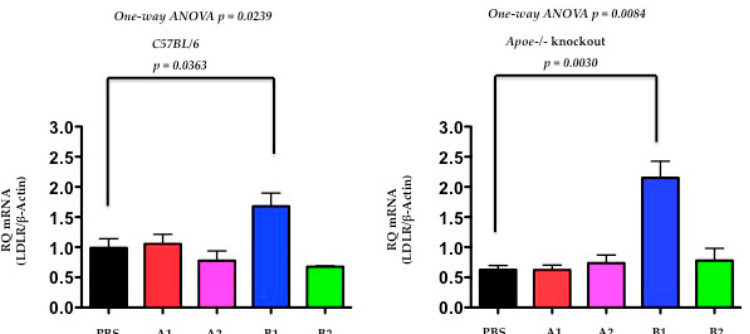
Figure 6. The hepatic mRNA levels of LDL receptor were significantly increased at day 120 after X-PCSK9-B1 treatment in both C57BL/6J and Apoe − / − mice. The authors extracted total RNA from mouse liver at day-120 after X-PCSK9 immunogen treatment. The authors used real-time RT-PCR to quantify the mRNA levels of LDL receptors (LDLR). The results are expressed as RQ (LDLR mRNA normalized with β -Actin; mean ± SEM, black = PBS; red = X-PCSK9-A1; pink = X-PCSK9-A2, blue = X-PCSK9-B1 and green = X-PCSK9-B2). Statistical analyses were performed using two-tailed unpaired t -test with Welch’s correction . The differences of X-PCSK9-B1 treated vs. PBS were significantly different in both C57BL/6J and Apoe − / − mice ( p = 0.0363 and 0.0030, respectively). One-way ANOVA